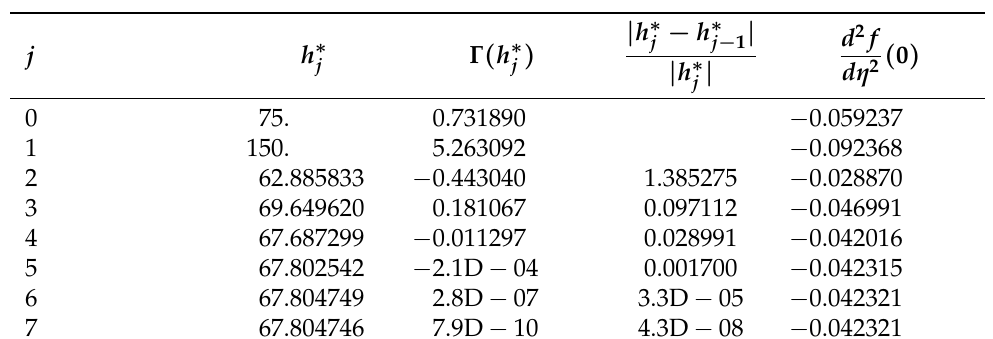
Table 3. Iterations for β = − 0.01 with